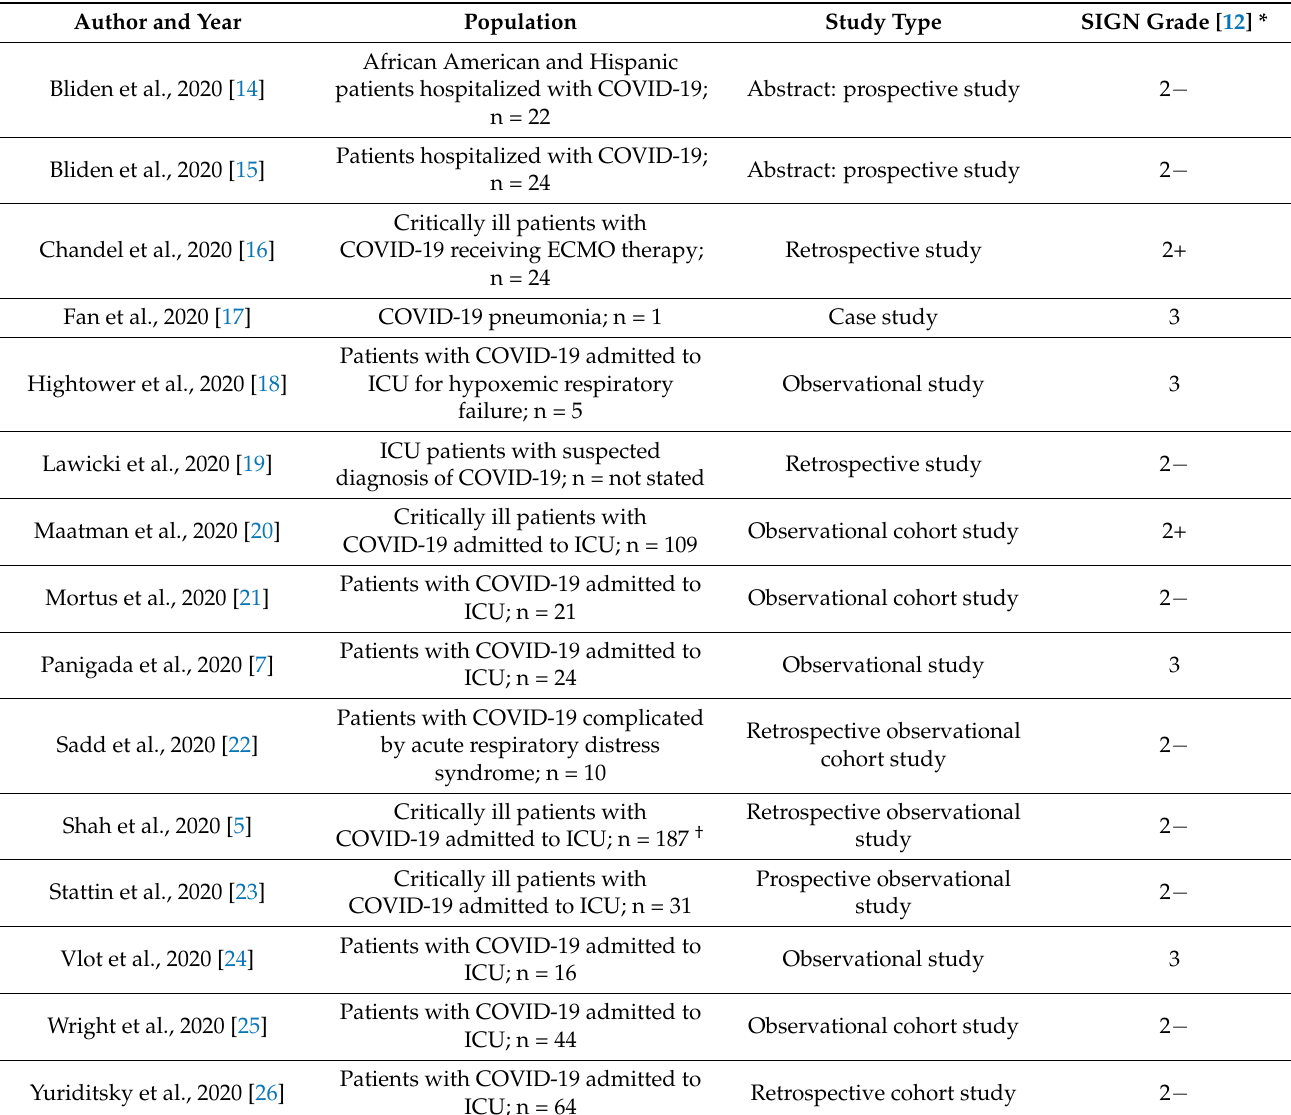
Table 1. Overview of included